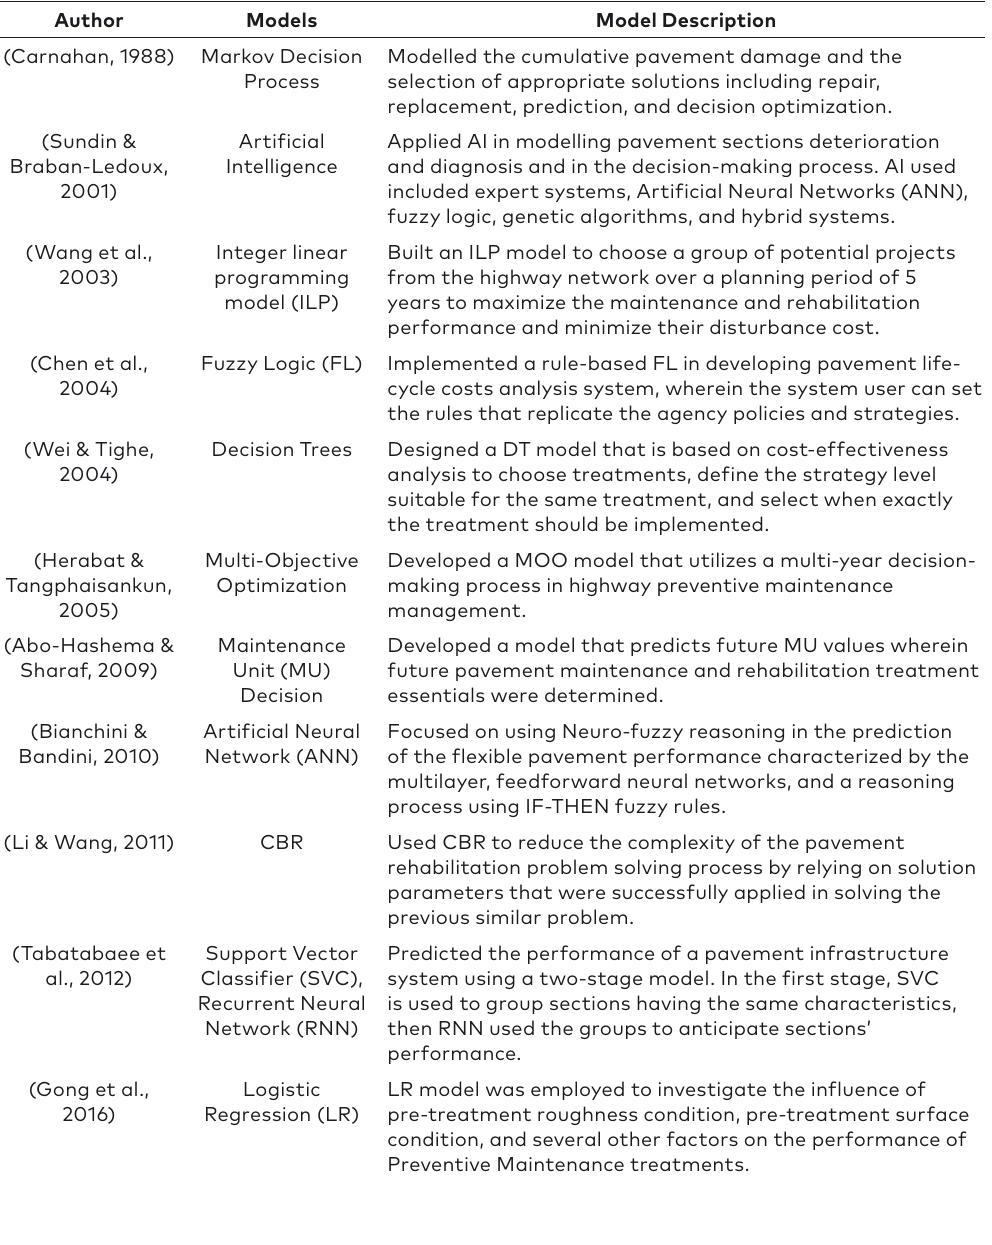
Table 1. Summary of the previous models to assess pavement